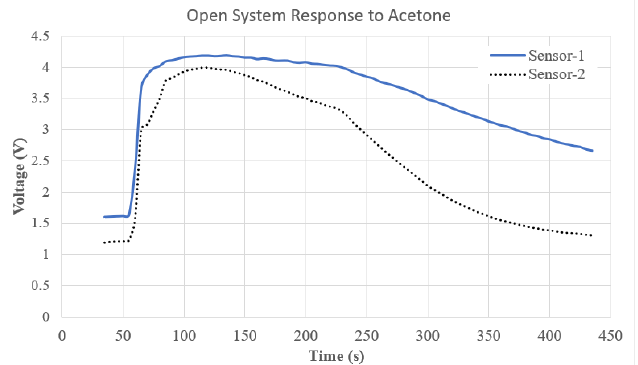
Figure 2. Responses of Sensor-1 and Sensor-2 placed in the third chamber of the system to acetone introduced in the second chamber at 0.5